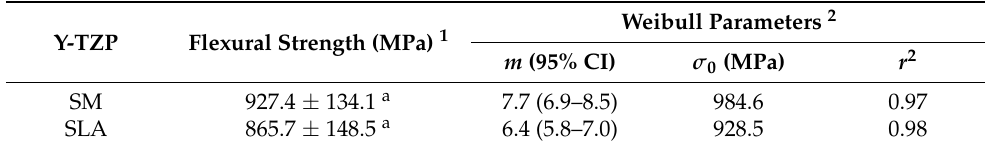
Table 1. Grain size/phase fraction results derived from the EBSD data (Figure 4).